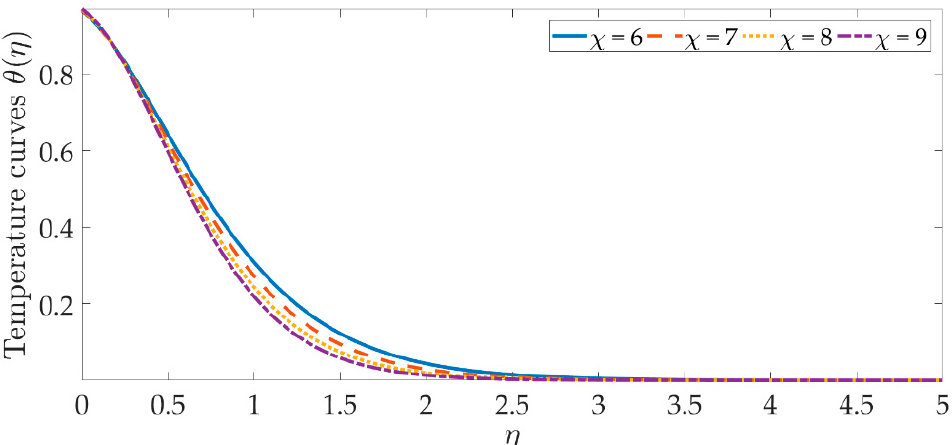
Figure 11. Temperature curves against the multiple values of ω t .